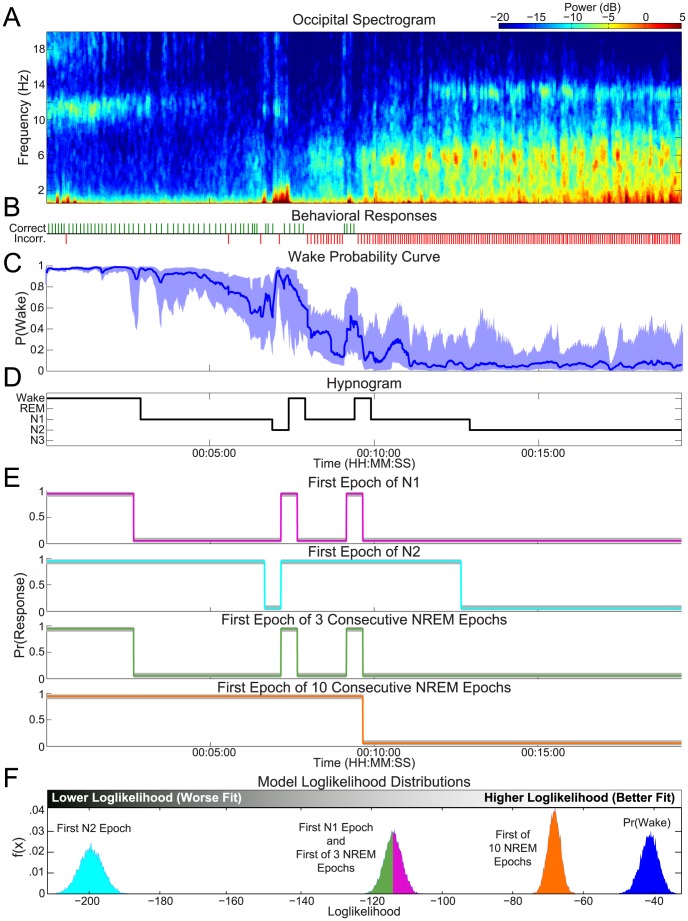
Heterogeneity in healthy subjects: An SOP phenotype with alpha power dropout before the cessation of behavioral activity.The (A) spectrogram, (B) behavioral responses, (C) the wake probability curve, (D) and the clinical hypnogram are shown for a subject with this SOP. The wake probability curve captures persistence of behavioral responses after alpha power declines, a feature that is not evident in hypnogram-based binary models of sleep onset (E). The Bayesian likelihood analysis (F) shows that wake probability significantly outperforms (99.99% Bayesian credible interval of the difference distribution falls above zero) all of the instantaneous transition models in the ability to correctly predict the behavioral responses for this subject.